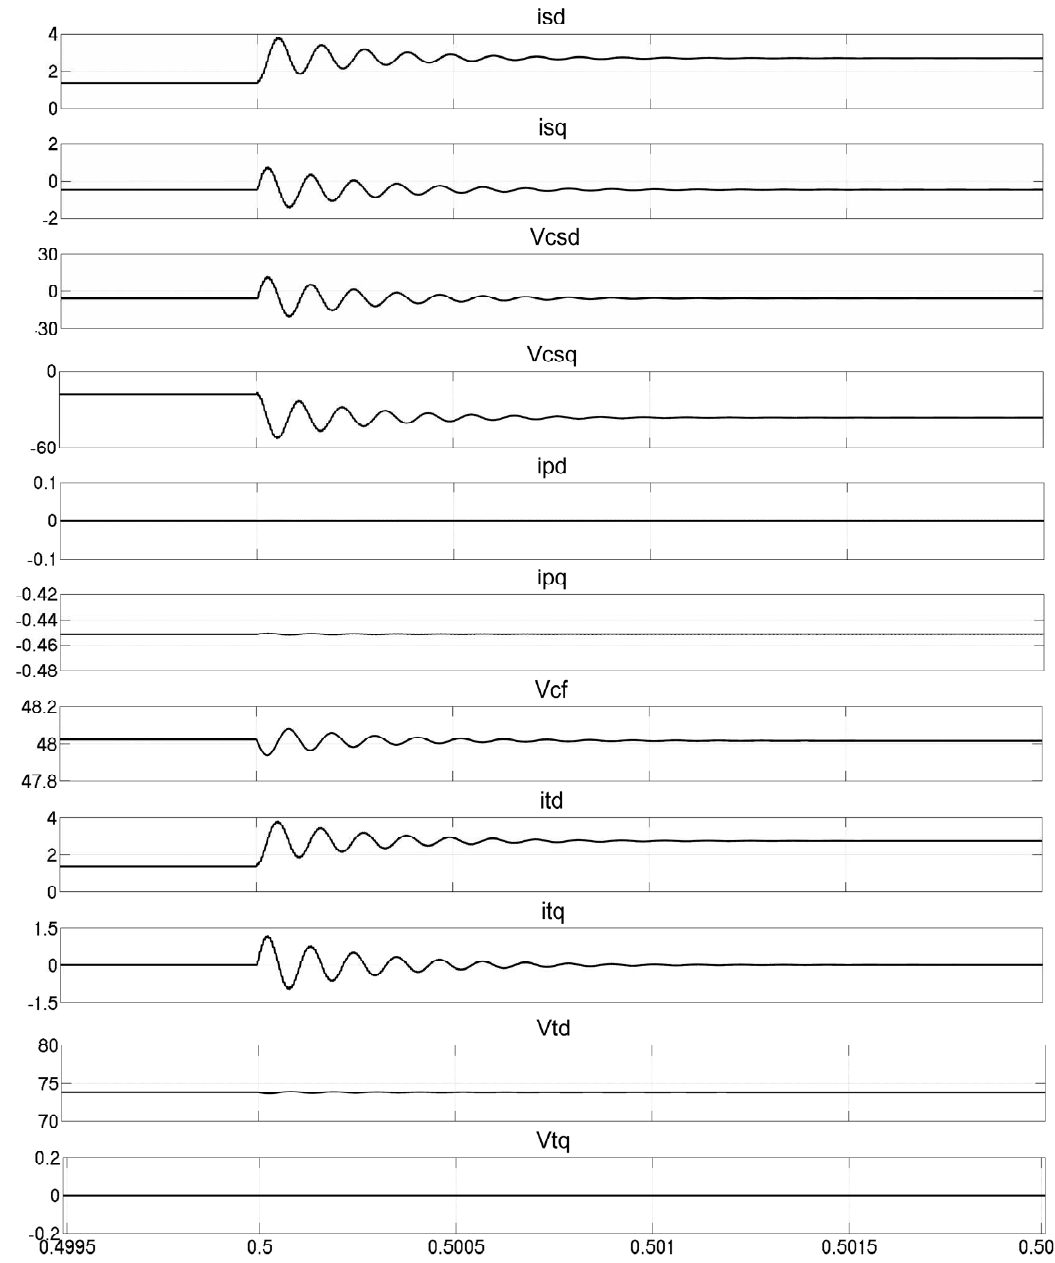
Figure 8. Simulation results from MATLAB/Simulink. From top to bottom: i v , i , i , v , i , i , v , v Csq pd pq Cf td tq td tq